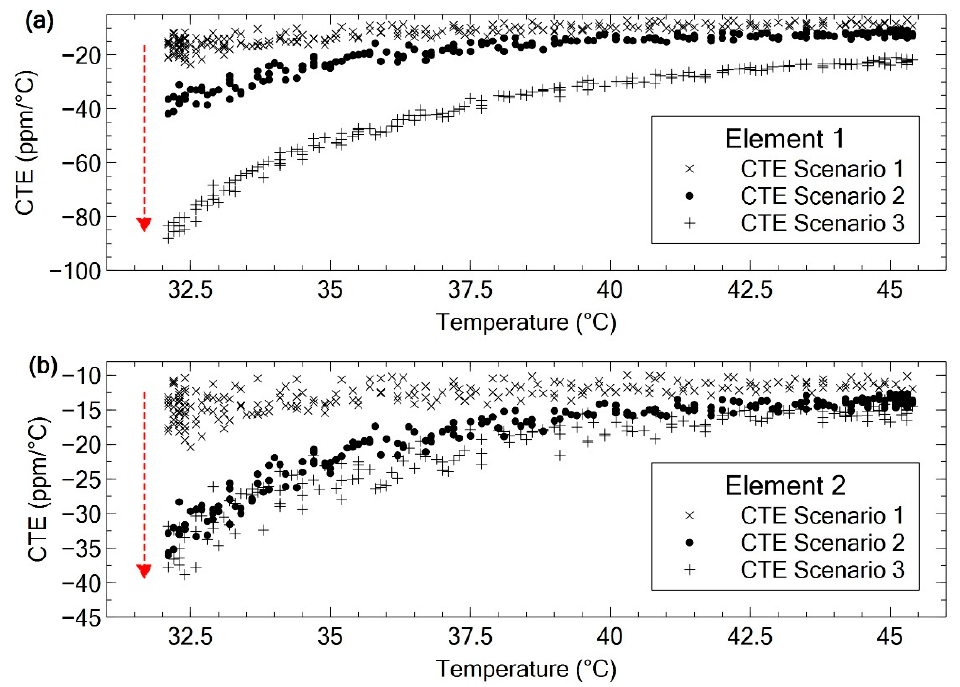
Figure 19. Changes in CTE due to various o ff set positions. ( a ) Changes in CTE for element 1 of strain gauge; ( b ) Changes in CTE for element 2 of strain